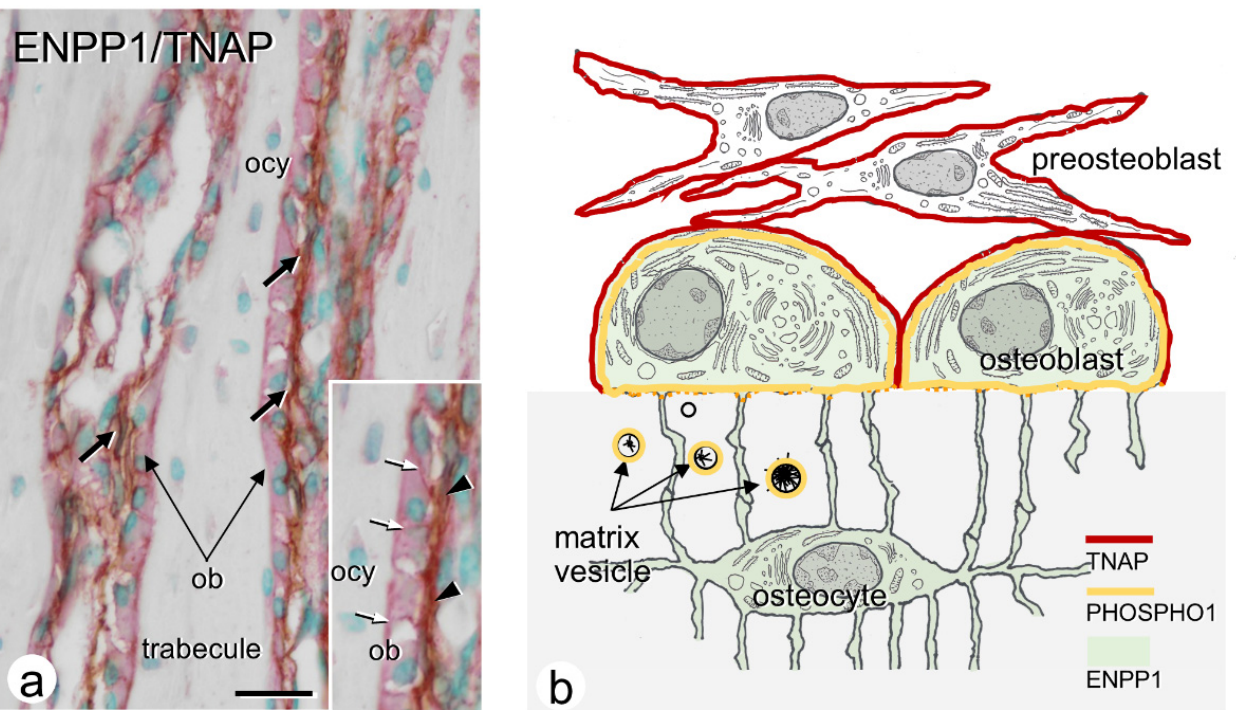
Figure 2. Immunolocalization of TNAP and ENPP1. ( a ) Double detection of TNAP (brown) and ENPP1 (red). Note preosteoblasts (pre-ob) and the baso-lateral sides of osteoblasts (ob) show an intense reactivity of TNAP (brown), while the cytoplasm of osteoblasts and osteocytes (ocy) reveals ENPP1 reactivity (red). ( b ) A schematic design of the distribution of TNAP (red lines), ENPP1 (green color), and PHOSPHO1 (yellow lines). Panel a and b are modified from Ref. [54]. Adapted with permission from Ref. [54]. 2021, Elsevier. Bar, 15 mm ( a ).